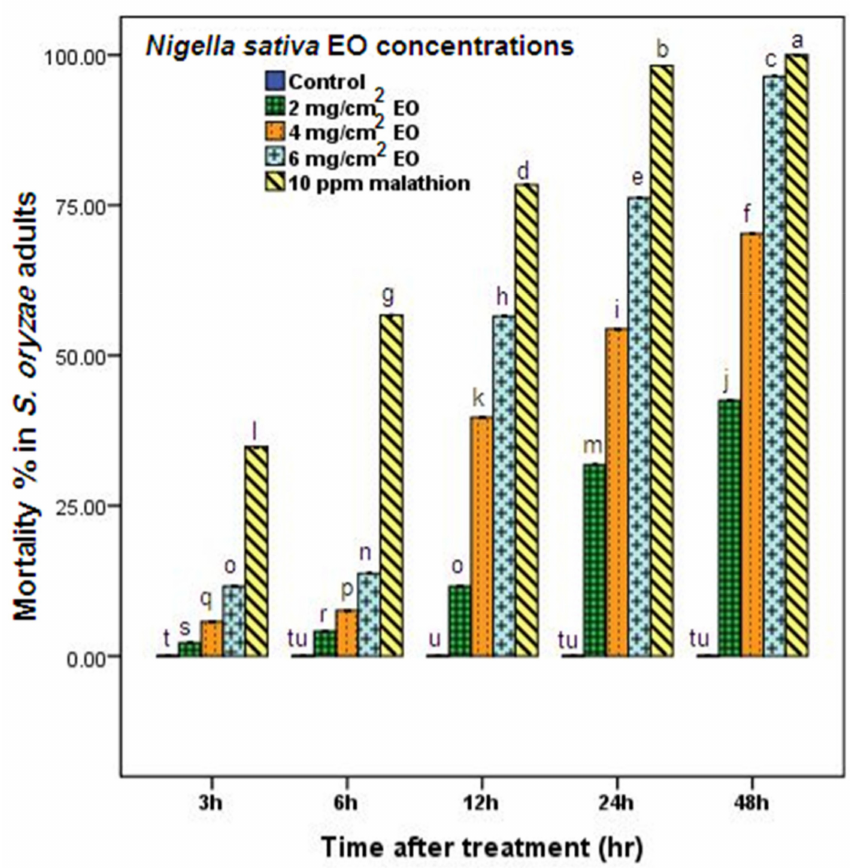
Figure 2. Impact of different concentrations (2, 4, and 6 mg/cm 2 ) from N. sativa EOs on mortality of S. oryzae adults at 3, 6, 12, 24, and 48 h exposure times (mean ± SD) compared with standard chemical pesticide (10 ppm malathion). Different letters indicate significant differences between different treatments at p < 0.05; LSD =